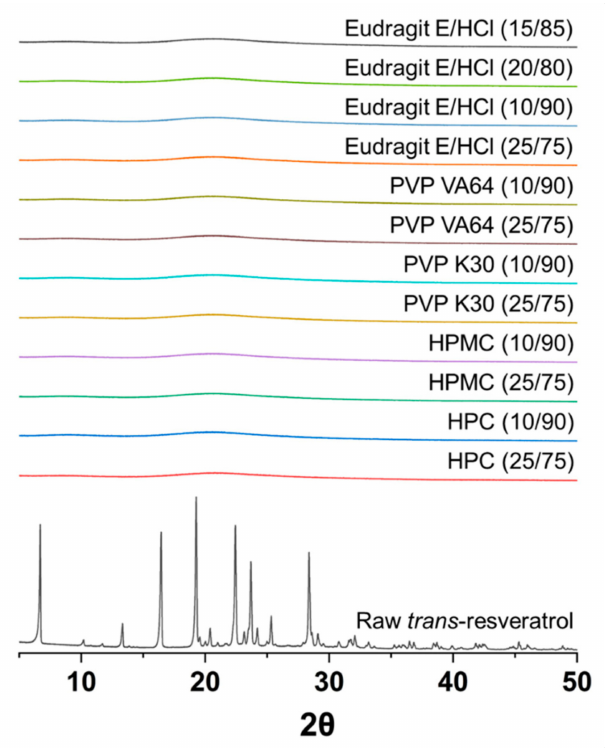
Figure 1. Scanning electron microscope images of raw trans -resveratrol and solid dispersion powders produced using the spray drying process.